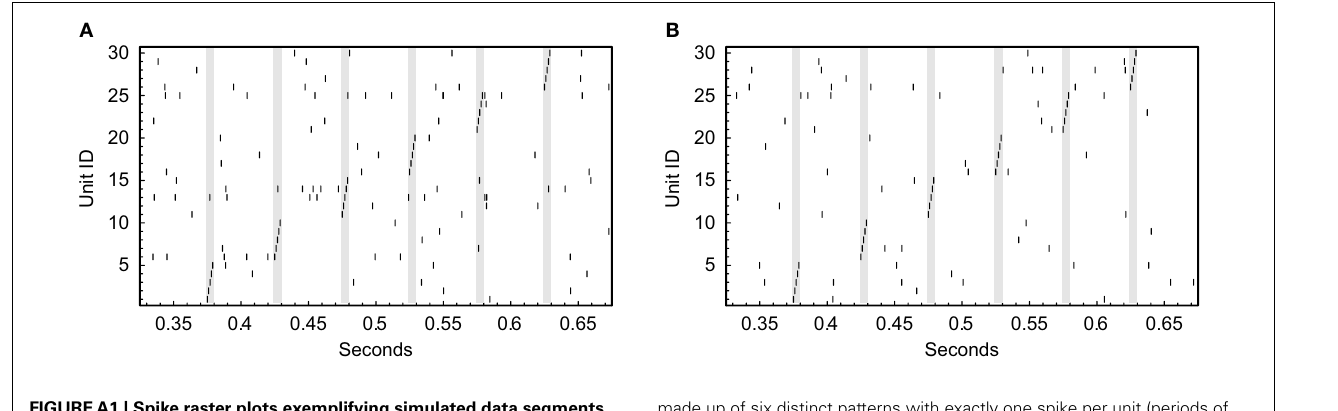
FIGUREA1 | Spike raster plots exemplifying simulated data segments including inserted spatiotemporal patterns and pattern sequences . Thirty parallel spike trains were generated by gamma processes with rate parameter β =49 and random shape parameter α =0.7–7. Patterns consisted of five spikes with millisecond intervals and followed each other with an onset delay of 50ms, giving rise to a synfire chain-like structure